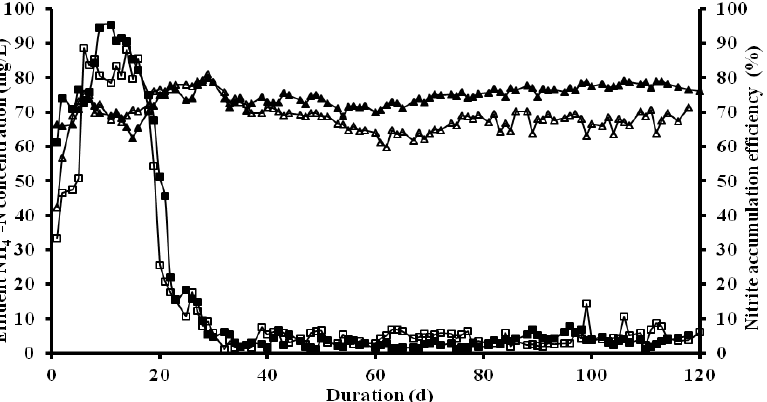
Figure 2. Performance of effluent NH 4+ -N concentration and NO 2 − -N accumulation efficiency in SBRs ( (cid:4) : effluent NH 4+ -N in IASBR; (cid:3) : effluent NH 4+ -N in CASBR; (cid:78) : NO 2 − -N accumulation efficiency in IASBR; ∆ : NO 2 − -N accumulation efficiency in